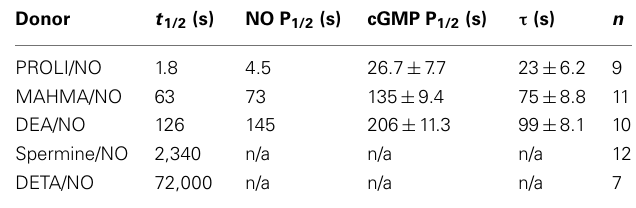
Summary table of the NO donor half-life (t 1/2 ), the NO peak width at half-maximal stimulation (NO P 1/2 ), as well as the cGMP peak width at half-maximum (cGMP P 1/2 ),cGMPpeakdecayrate( τ )asmeasuredby δ -FlincG,andnumberofreplicates is given for each NO donor.Values are represented as mean ± standard